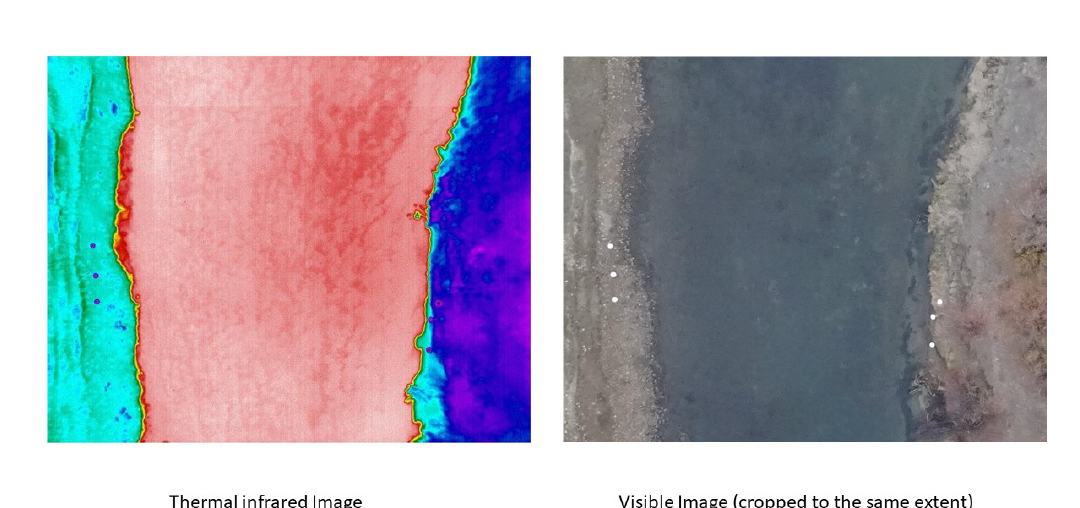
Figure 2. Imagery collected by sUAS camera platform over cross section 1. The aluminum disks used as ground control points appear as dark purple circular features in the thermal image and as white circles in the visible